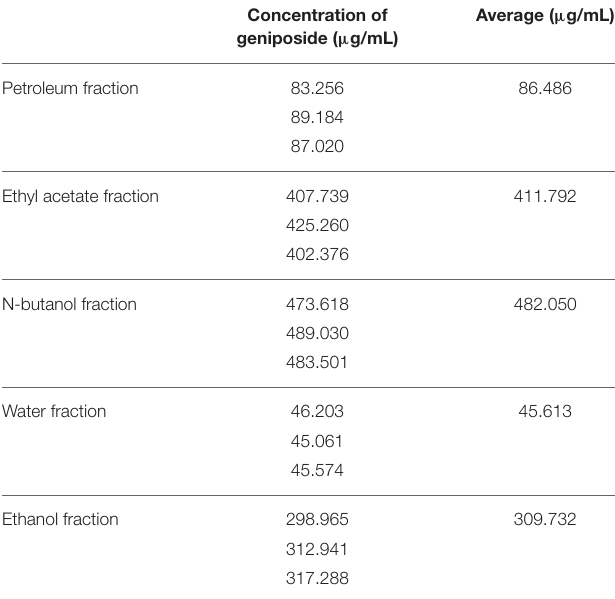
TABLE 2 | The concentrations of geniposide in different fractions derived from